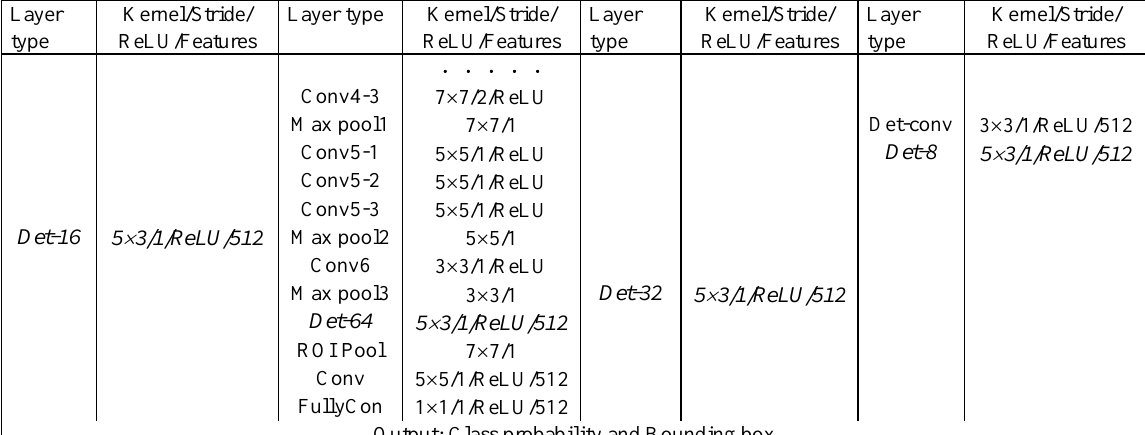
Table 2. Architecture of MS-CNN